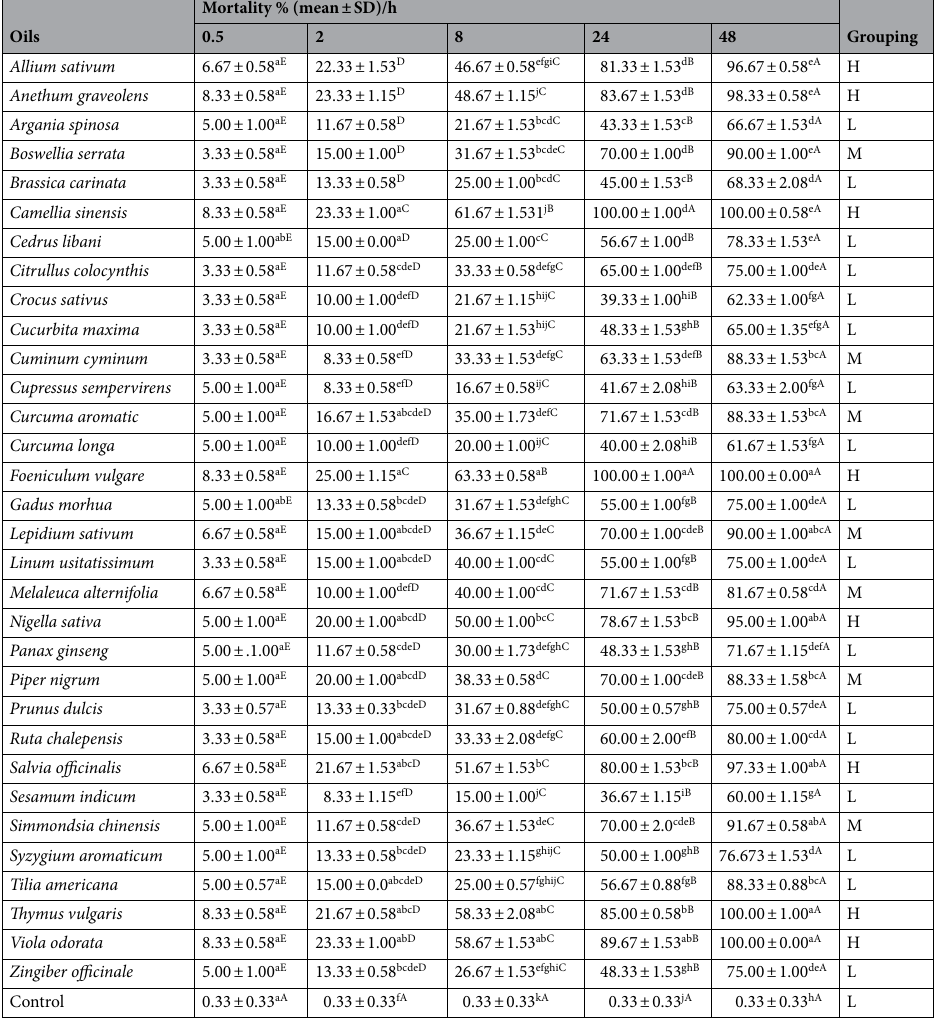
Table 2. Larval mortality (%) of plant oils used at 1000 ppm through different time periods. Numbers of the same raw followed by the same small letter are not significantly different (one-way ANOVA, Duncan’s MRT, P > 0.05). H: The highly effective (95–100% mortalities), 8 oils. M: The moderately effective group (81–92% mortalities), 7 oils. L.: The moderately effective group, include the rest of oils, 17